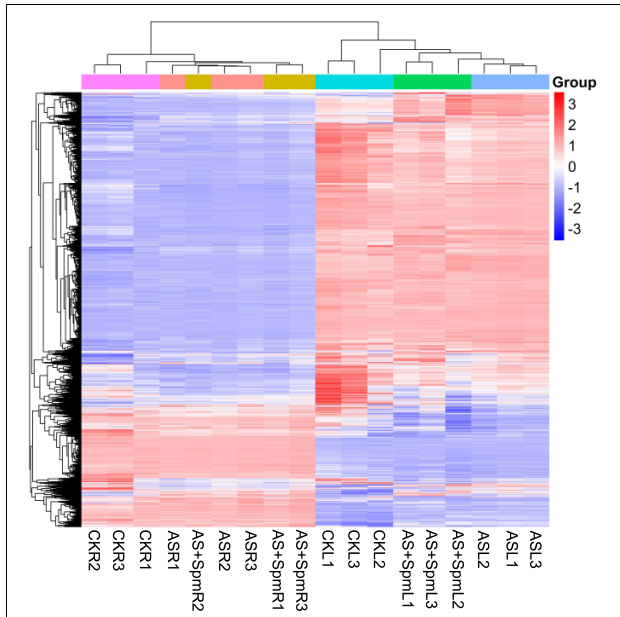
FIGURE 2 | Principal component analysis among all the replicates and treatments. CK, control; AS, alkali stress (35 mmol.L − 1 Na 2 CO 3 :NaHCO 3 = 1:1); AS + Spm, alkali stress + spermine (35 mmol.L − 1 Na 2 CO 3 :NaHCO 3 + 0.01 mmol.L − 1 spermine); R, root; L, leaf, 1, replicate 1; 2, replicate 2; 3, replicate